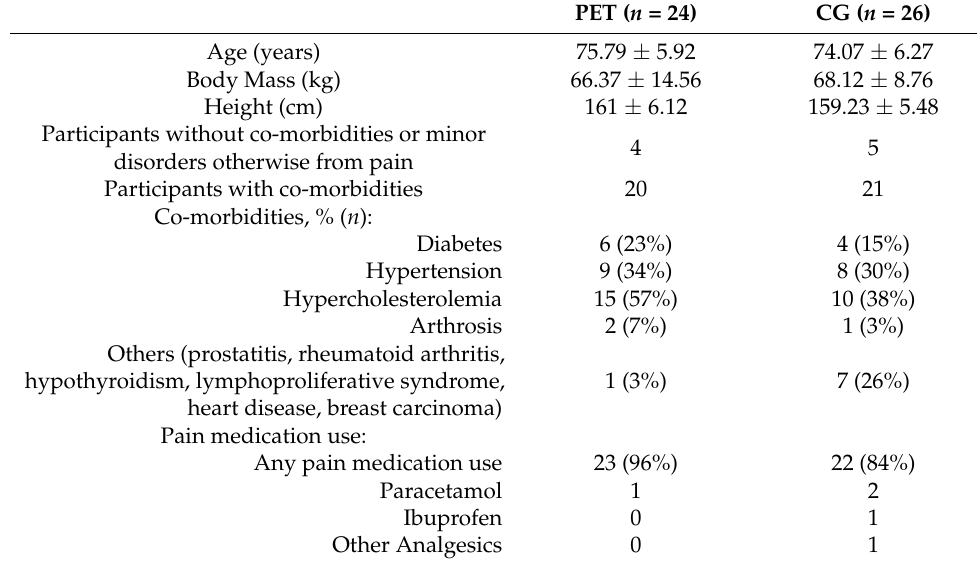
Table 2. Anthropometric and sociodemographic characteristics of the sample.